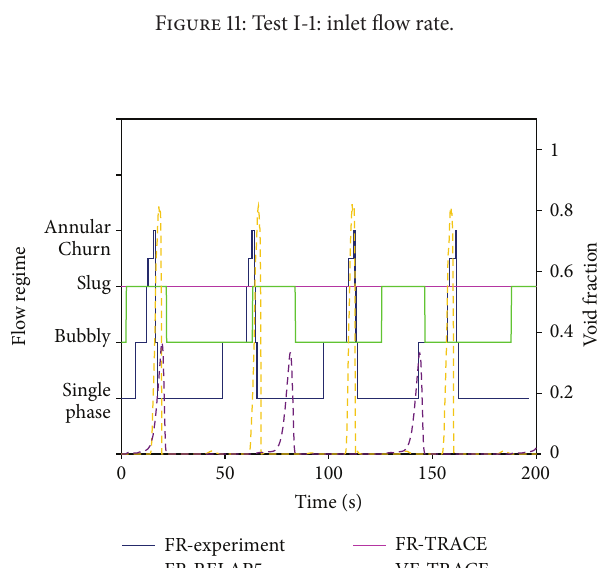
Figure 11: Test I-1: inlet flow rate.